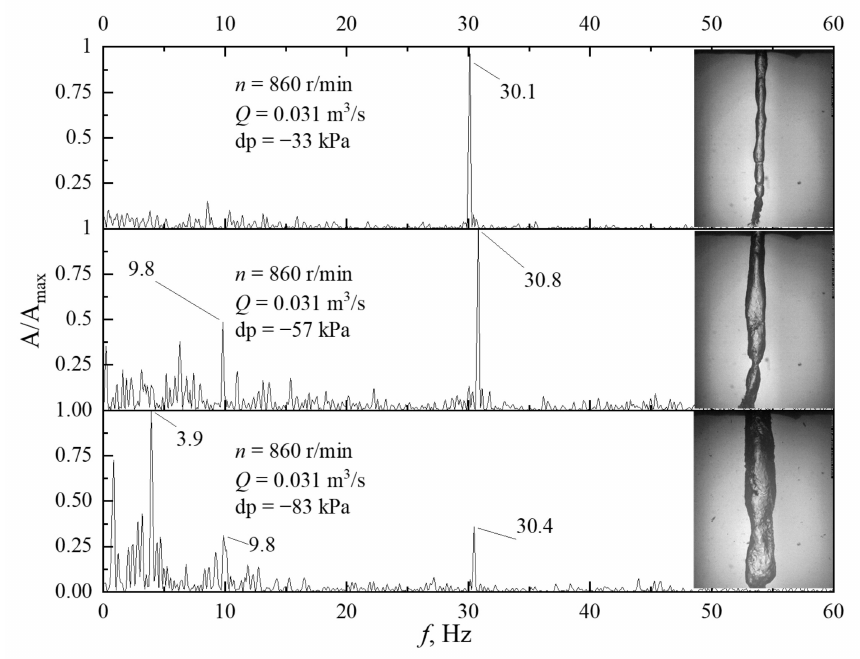
Figure 8. Pressure spectrums and flow patterns for different dP cases at n = 860 r/min and Q = 0.031 m 3 /s ( S =